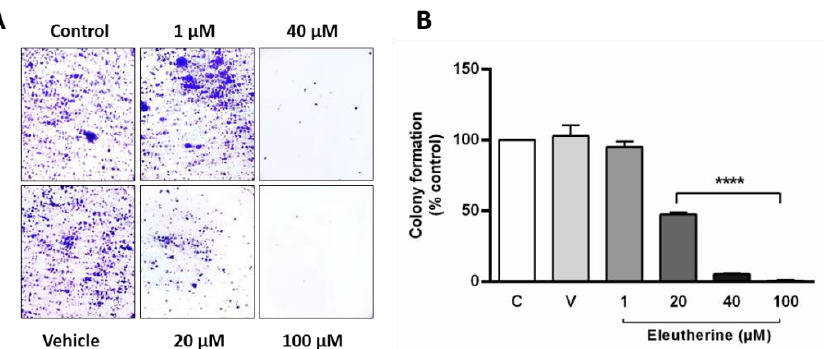
Figure 5. Eleutherine reduces colony formation in C6 cells. ( A ) C6 cells stained with crystal violet after eleutherine treatment for 12 h. ( B ) Graphic quantification of the colony numbers. Data are presented as the mean ± SEM of three independent trials. Here, **** p < 0.0001 vs. untreated control (ANOVA, Tukey’s post hoc test).